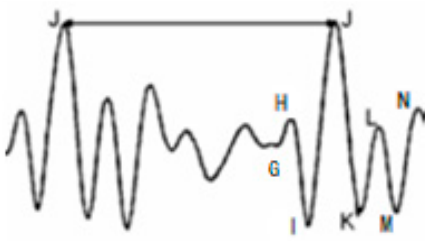
Figure 2. Typical BCG signal. Each BCG signal is characterized by several peaks and troughs reflecting specific events of the beating heart. The BCG of a complete cardiac cycle includes G, H, I, J, K, L, M, and N waves. J peak is the peak with the maximum amplitude produced when the heart beats at its maximum, I is the trough with the minimum amplitude before J peak, H is the peak before J peak, K and M are the troughs after J peak, and L and N are the peaks after J peak. The whole cardiac cycle can be divided into three parts: prosystolic (GH), systolic (IJK), and diastolic (LMN).